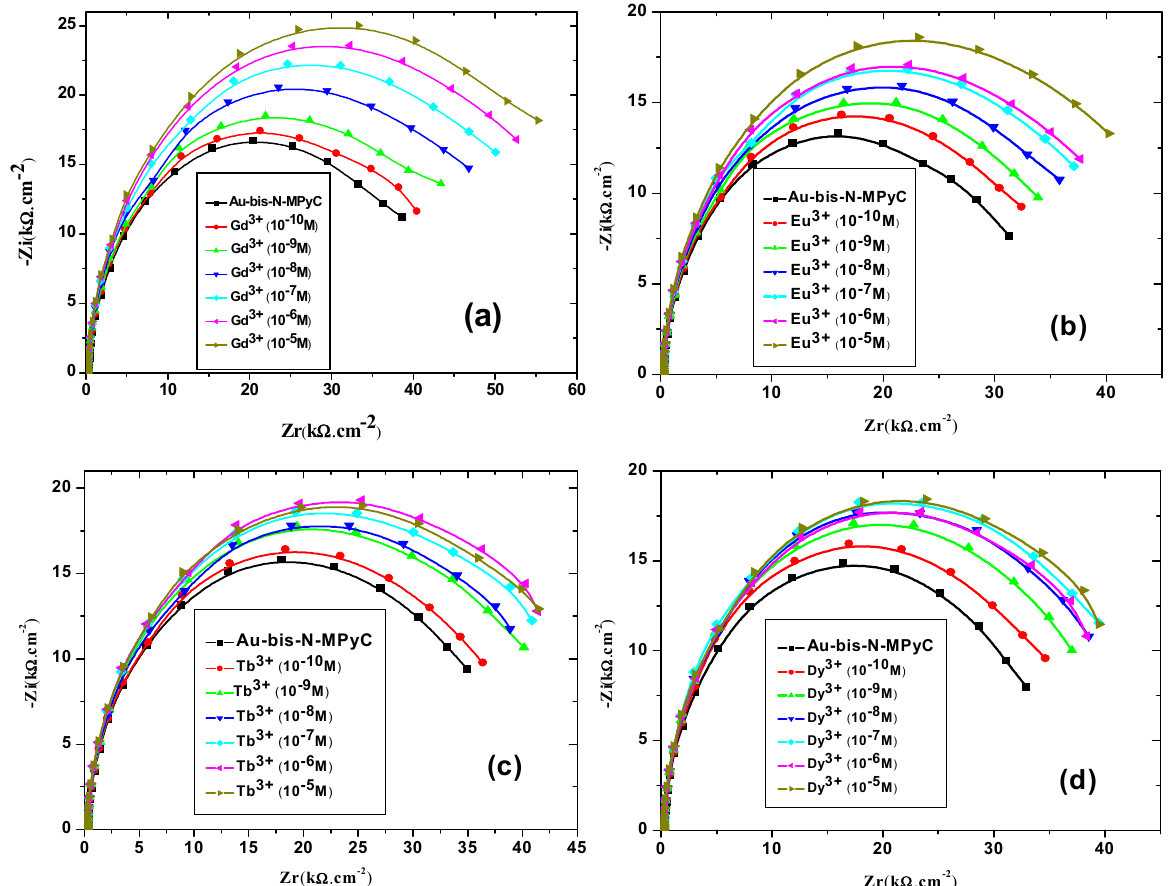
Figure 10. Nyquist diagrams of the gold electrodes coated with bis-N-MPyC thin film in ammonium acetate 10 − 2 M at pH 6.8 for different concentrations of lanthanides Gd 3+ ( a ), Eu 3+ ( b ), Tb 3+ ( c ) and Dy 3+ ( d ).